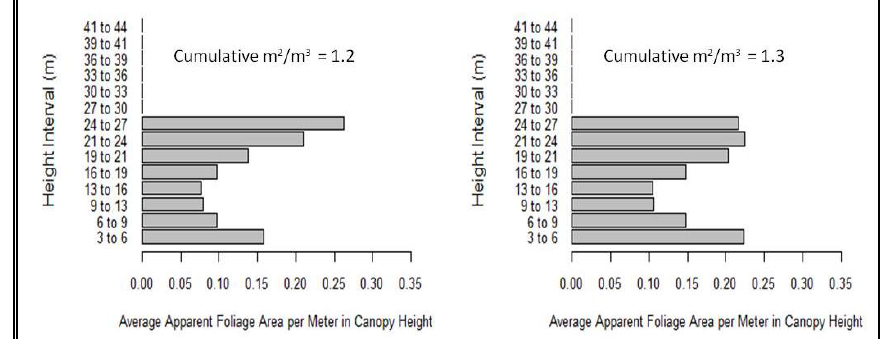
Figure 15. The apparent average foliage area profile for sample areas of HBEF that coincide with canopy layer structure category 6, divided into 3 m height intervals. The shape of the profiles shows peaks in the foliage area above 15 m and below 7.5 m. This coincides with the definition of category 6, which has more canopy material in the overstory and understory than the